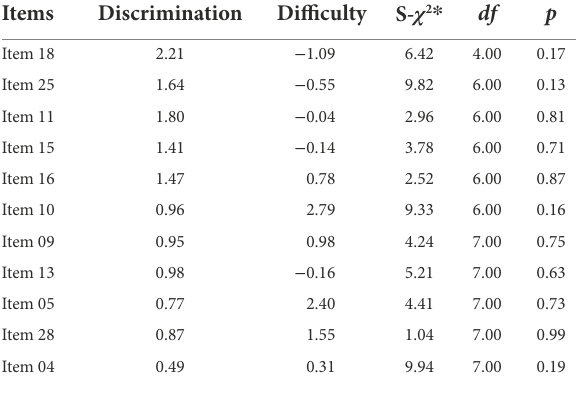
TABLE 7 Item discrimination, difficulty and item fit statistics of Bangla Rotter I-E Scale with 11 items ( N =